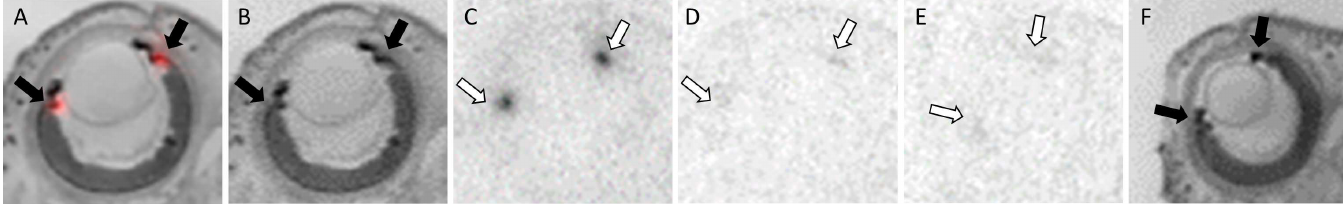
Fig 2. OXTR ligand binding in the eye of a P0 male mouse. Pseudo-color composite (OXTR in red, cresyl violet counterstain in gray) (A), followedby cresyl violet counterstain (B), with black arrows indicating regionof interest. OXTR ligandbindingis indicatedby white arrows in the 0 nM OXT competition (C), followedby 1000 nM OXT competingwith OVTA radioligand to reduce the signal (D). OXTR ligandbindingwas not present in OXTR KO mice (E), followedby the post-processed cresyl violet tissue of the OXTR KO (F).